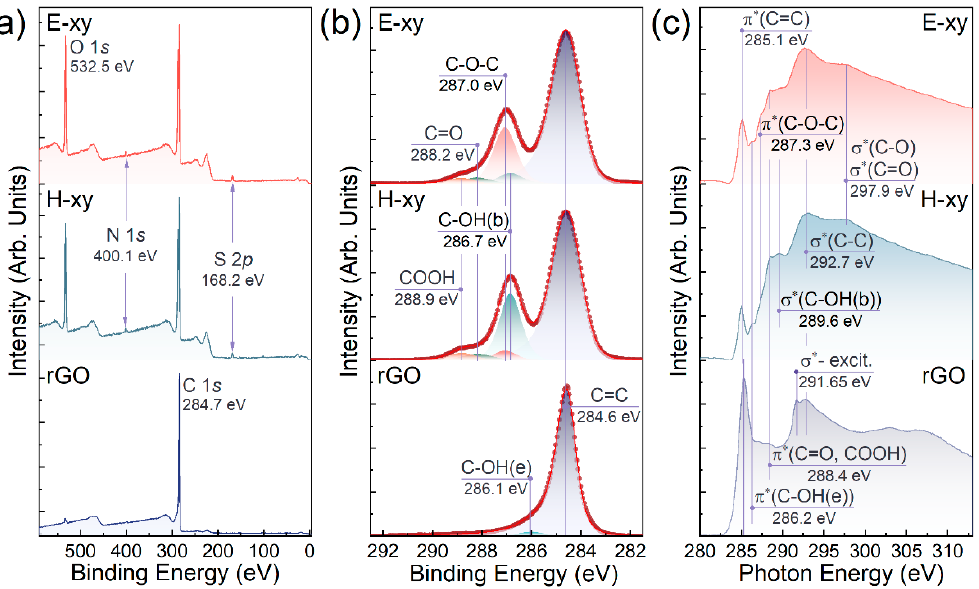
Figure 3. X-ray photoelectron examination of the CMG chemistry. ( a ) Survey and ( b ) core-level C 1 s X-ray photoelectron spectra of the E-xy graphene, H-xy graphene, and rGO. ( c ) C K -edge X-ray absorption spectra of the investigated materials.